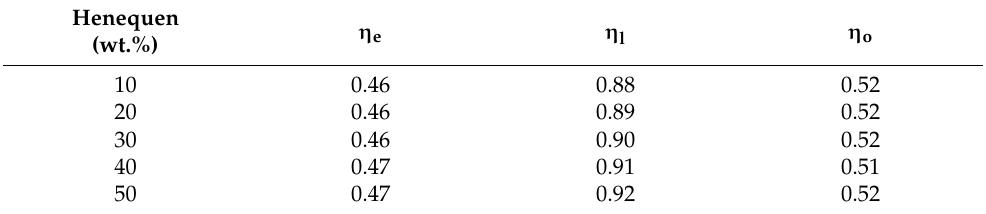
Table 3. Modulus efficiency ( η e ), length ( η l ), and orientation ( η o ) factors for the henequen-reinforced PP